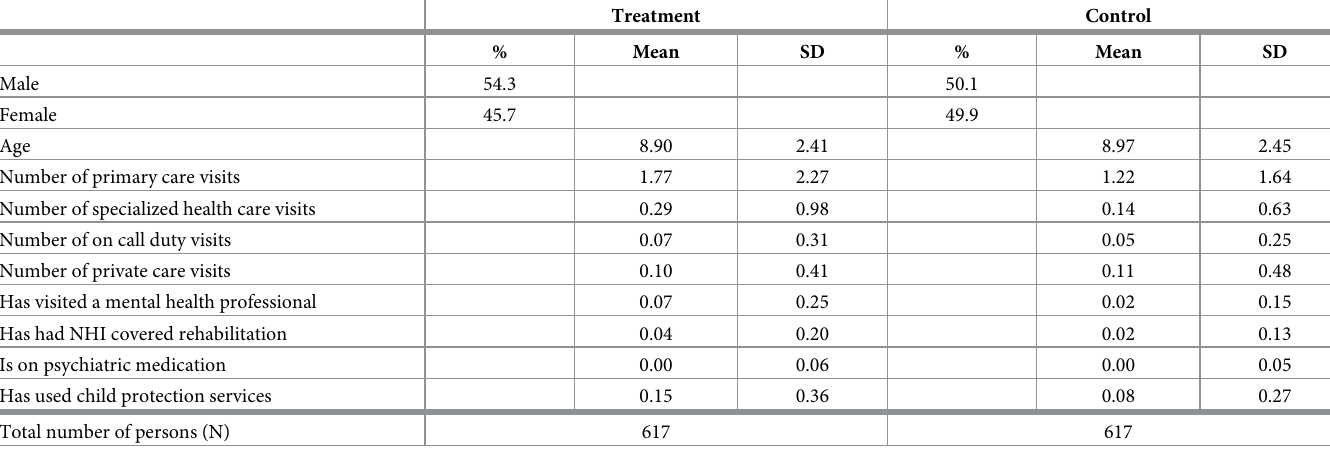
Table 1. Descriptive statistics per quarter for the treatment and control groups across the three-year follow-up